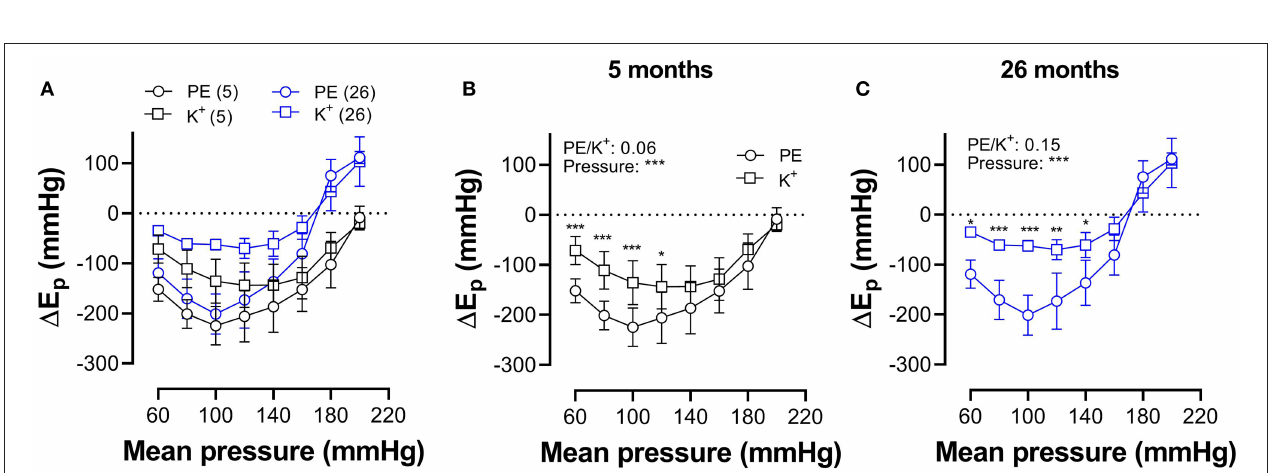
FIGURE 7 | Pressure-dependent hysteresis is affected by the contractile stimulus and by age. Data from Figures 5F , 6F are combined in Figure 6A for mice of 5 months ( n = 8, 5, black) and 26 months ( n = 5, 26, blue). Contractions by 50mM K + (squares) and 2 µ M PE (circles) were elicited in the presence of L-NAME. Three-way ANOVA: pressure: ***; age 0.12; stimulus *; pressure/age: **; pressure/stimulus ***; age/stimulus 0.73. For clarity, (A) was repeated in (B) (for 5 months) and (C) (for 26 months). Two-way RM ANOVA with Sidak’s multiple comparison test, * p < 0.05, ** p < 0.01, *** p < 0.001.